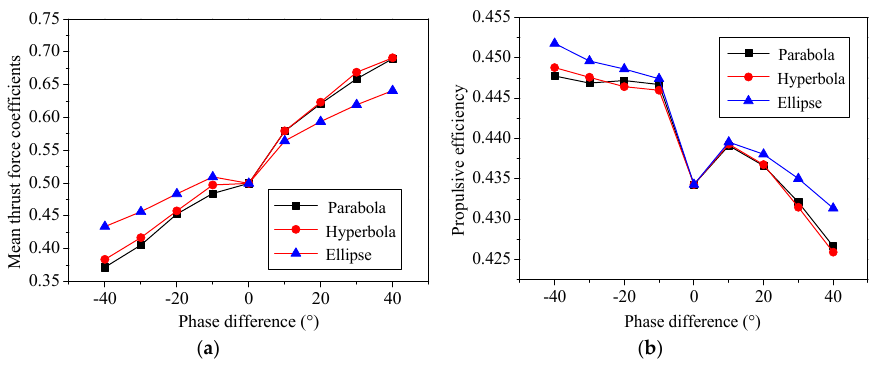
Figure 12. Performance curves versus phase difference of the NACA foil: ( a ) mean thrust force coefficients; ( b ) propulsive efficiency.